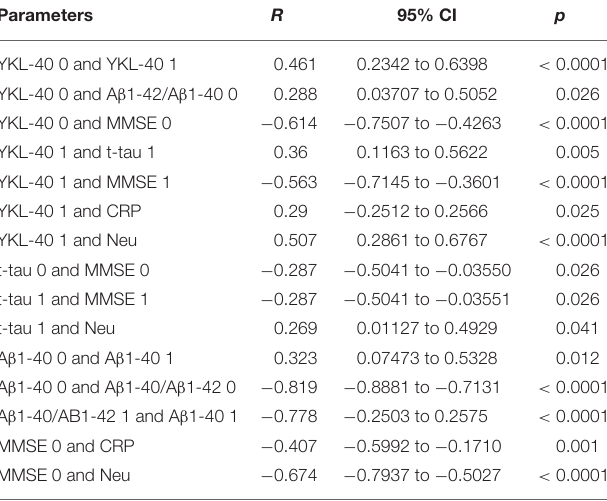
TABLE 2 | Statistically significant correlations found between MMSE, inflammatory parameters and analyzed biomarkers.